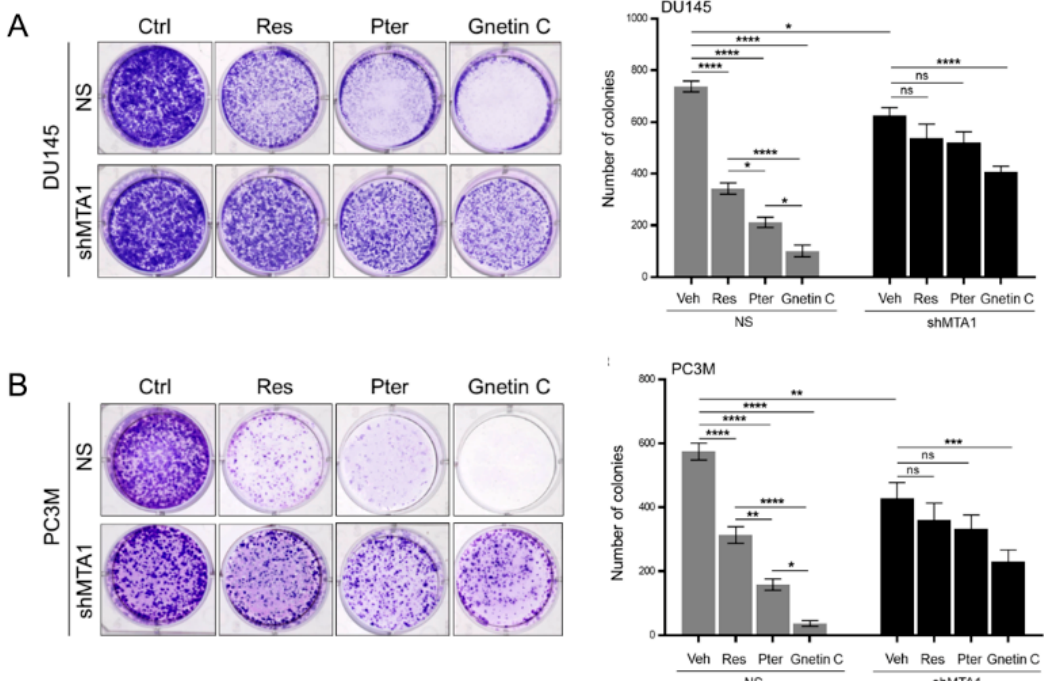
Figure 3. Gnetin C reduces MTA1-mediated clonogenic survival in PCa cells more potently than resveratrol and pterostilbene. ( A , B ) Representative images showing the colony formation ability of DU145 and PC3M MTA1 expressing (NS) and MTA1 knockdown (shMTA1) cells after treatment with 5 µ M of Res, Pter, and Gnetin C. Right , Quantifications of the number of colonies using ImageQuant software are shown for each cell line. Data represent the mean ± SEM of three independent experiments with duplicate wells. * p < 0.05; ** p < 0.01; *** p < 0.001; **** p < 0.0001 (one-way ANOVA).